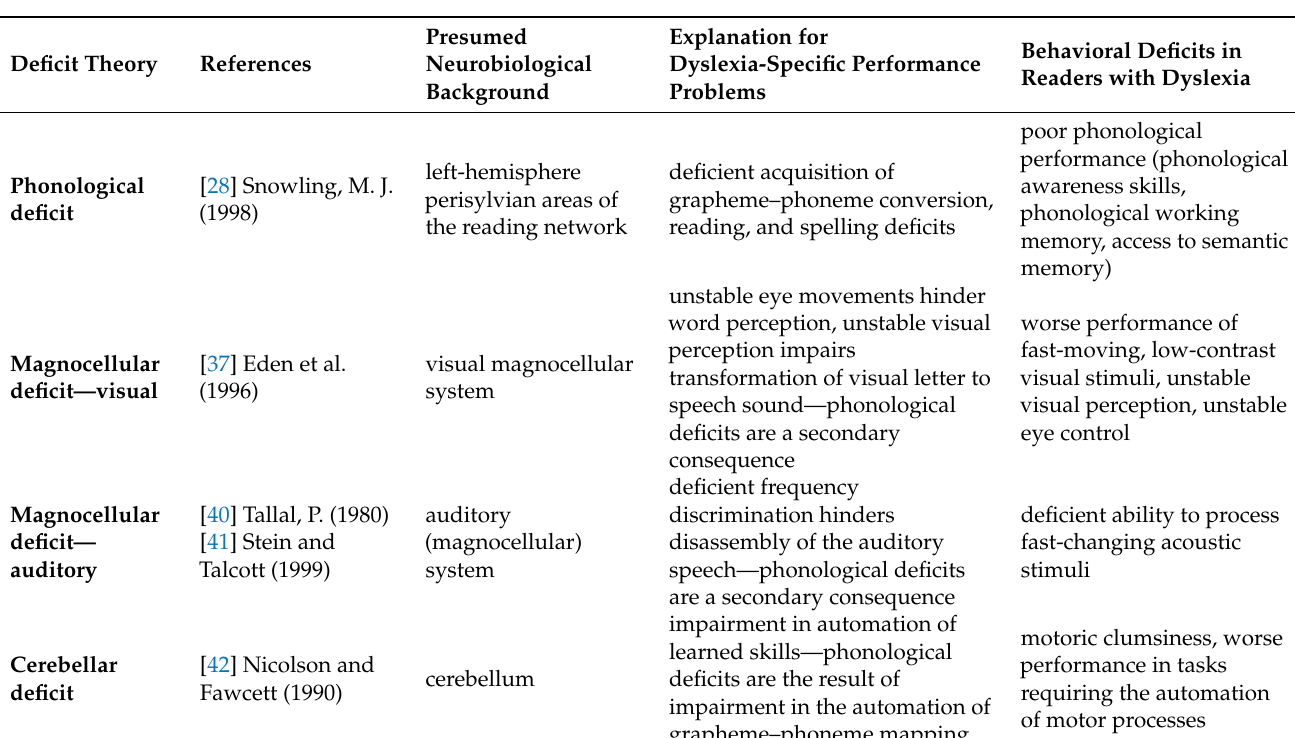
Table 1. Overview of the three theories in dyslexia